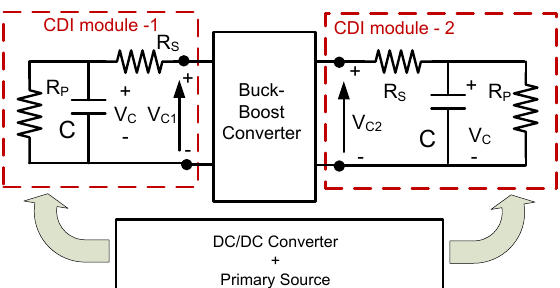
Figure 6. Desalination block diagram with a buck-boost converter for recovering energy